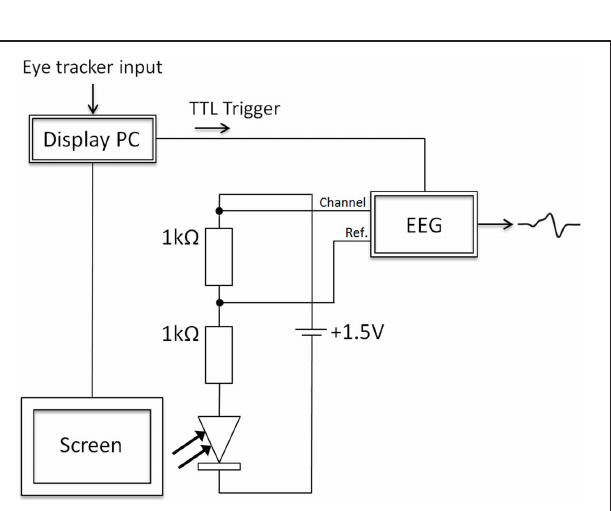
FIGURE 3 | (A) The power plugs for the original power supplies of the red, blue, and green LEDs of the projector used in the present setup (Samsung SP-F10M). (B) The projectors were mounted in a wooden box with the electronic circuit (mounted in an aluminum box) on top.